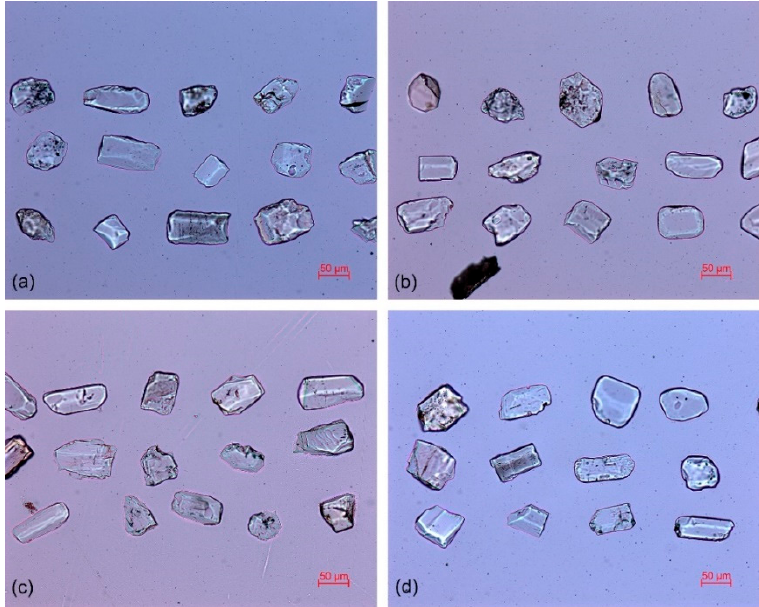
Figure 2. Transmitted-light photomicrographs showing examples of detrital apatites from the four sections of Core S3. Section 1 ( a ), Section 2 ( b ), Section 3 ( c ), and Section 4 ( d ).